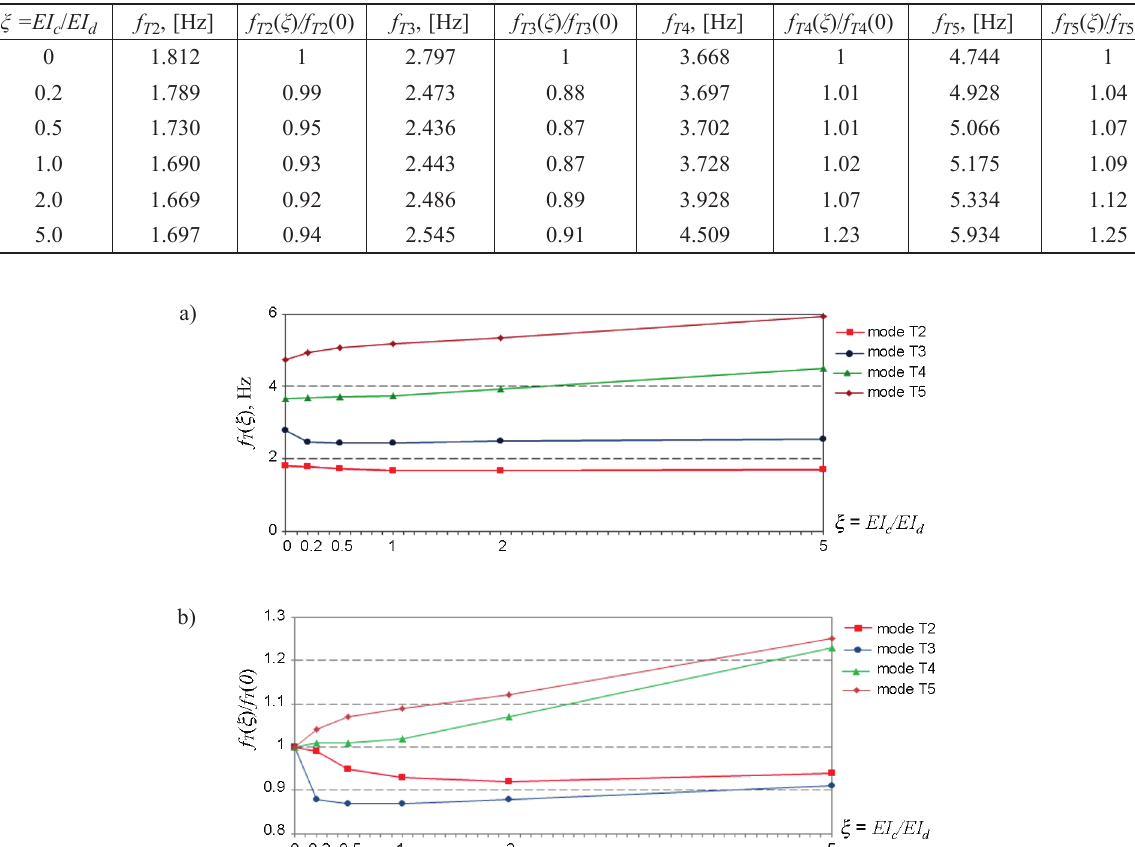
Table 3. Natural vibration frequencies and the frequency ratio of the first four torsional modes ξ =EI c / EI d